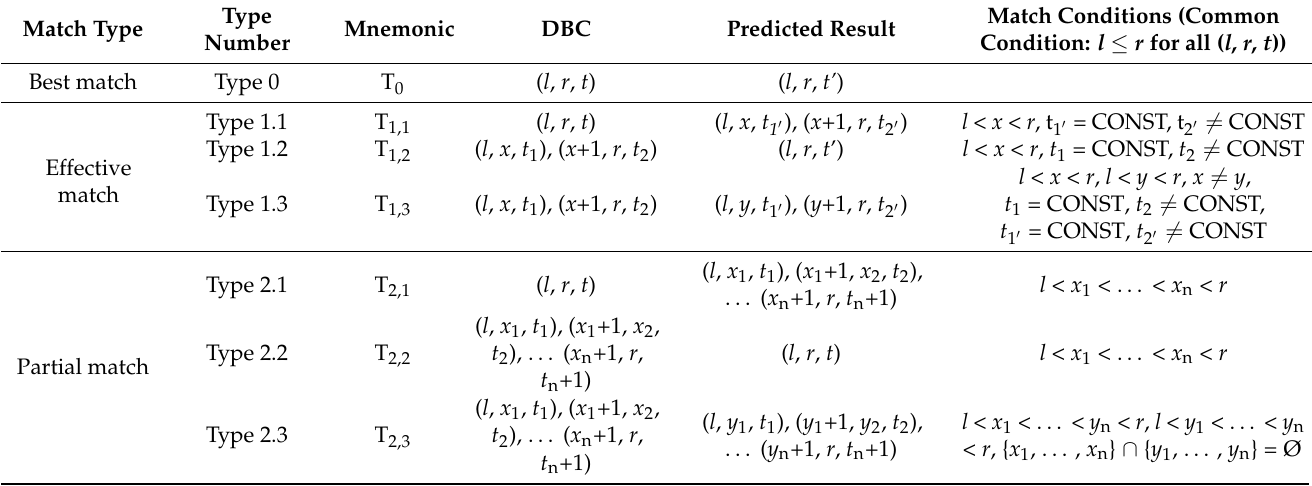
Table 6. Match conditions of match